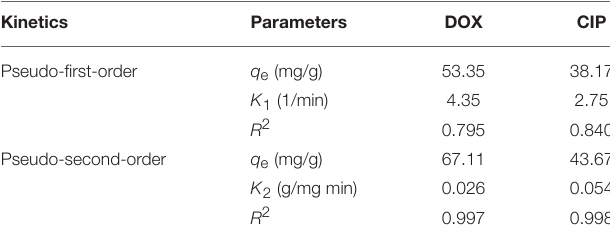
TABLE 1 | The model parameters and the corresponding correlation coefficient of kinetics models.